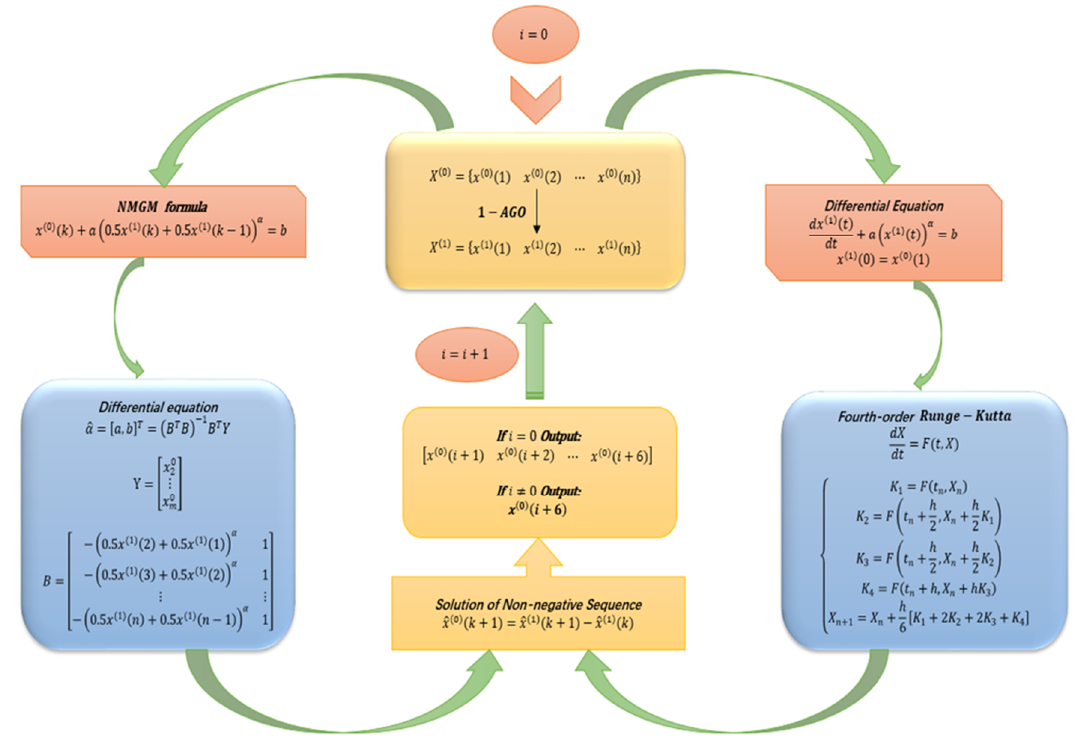
Figure 3. Method flow chart of NMGM (1,1) model.